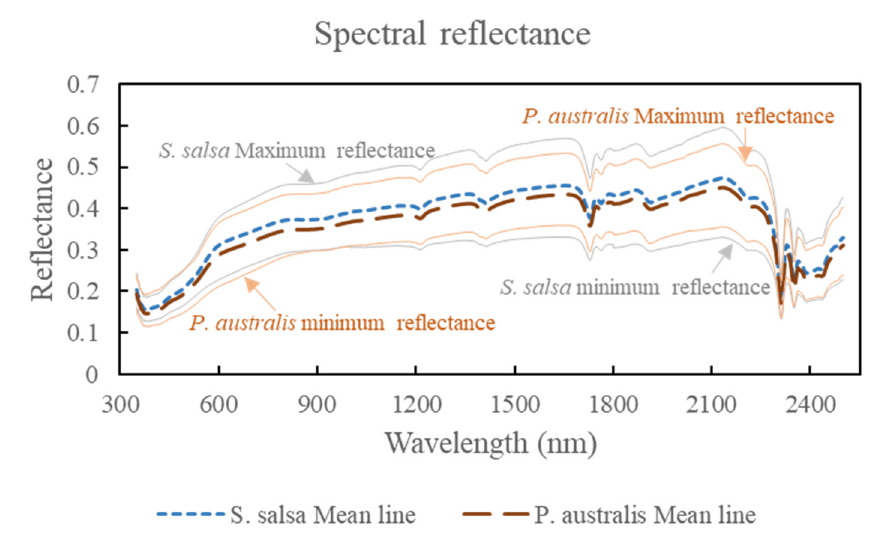
Figure 3. Spectral reflectance curves of P. australis and S. salsa.